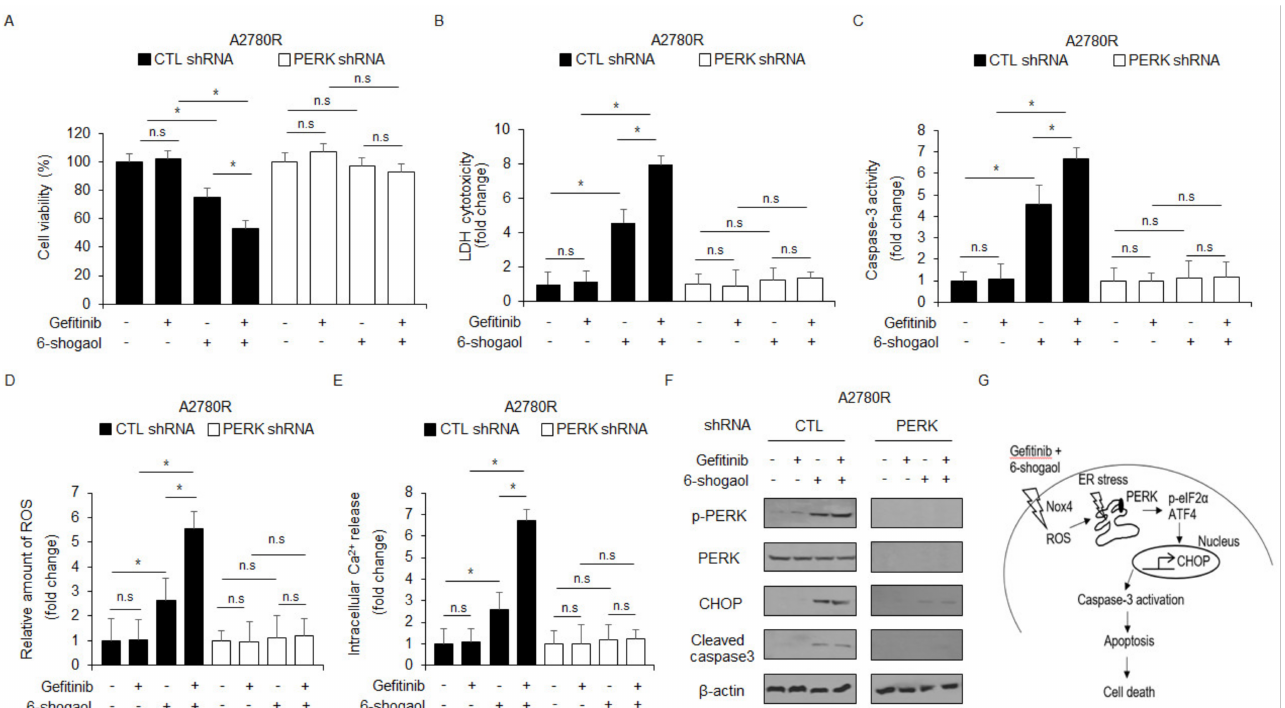
Figure 9. PERK knockdown blocks gefitinib/6-shogaol-mediated sensitivity in gefitinib-resistant A2780R cells. ( A – F ) After A2780R cells were transfected with PERK shRNA, PERK knockdown A2780R stable cell lines were established. These cells were treated with 6-shogaol (30 µ M, 24 h) and gefitinib (1 µ M, 24 h), and cell viability assays, LDH assays, caspase-3 activity assays, intracellular ROS assay, intracellular Ca 2+ assays, and Western blot analysis were performed to examine p-PERK, PERK, CHOP, and cleaved caspase-3 expression; *, p < 0.05. n.s = not significant. β -actin was used as a protein loading control. ( G ) Schematic representation of ER stress and apoptotic cell death signaling pathways induced by gefitinib plus 6-shogaol in ovarian cancer and gefitinib-resistant ovarian cancer